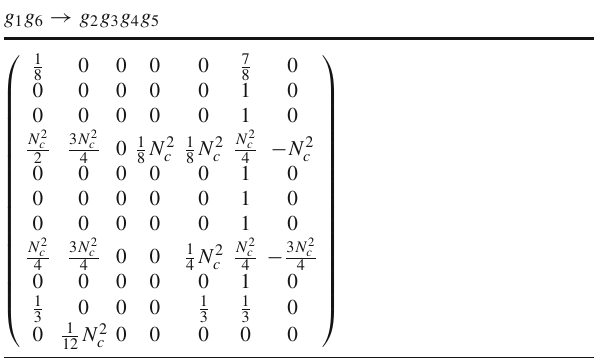
Table 13 The large N c limit of the matrices M from Table 8